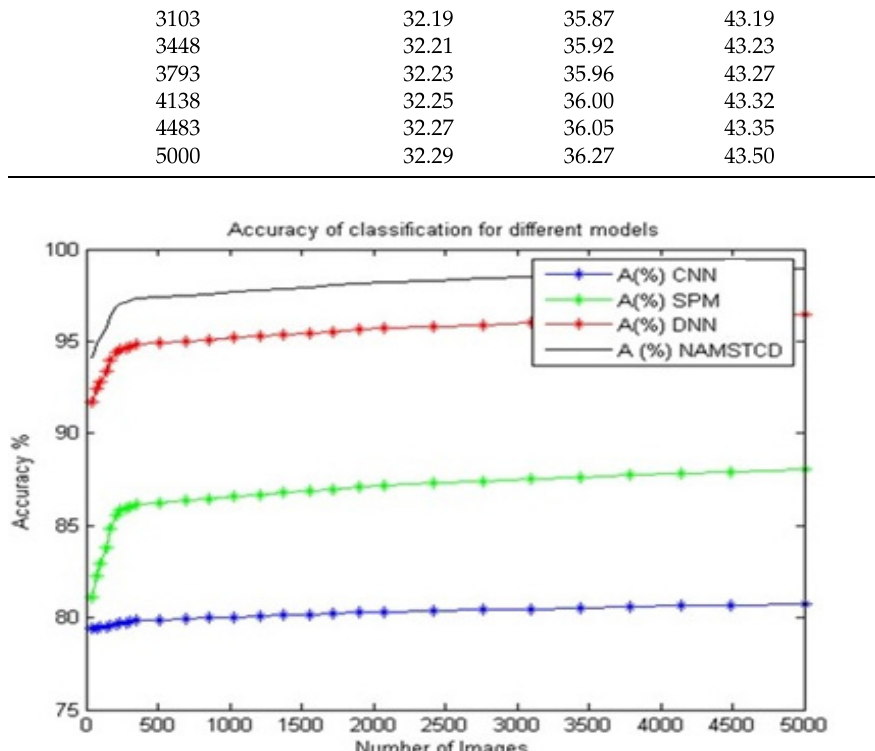
Figure 7. Accuracy of classi fi cation for di ff erent models. This suggests that the proposed model is highly e ffi cient for large-scale deployments and can be used in real-time clinical classi fi cation applications. Similarly, the PSNR during segmentation was evaluated for CNN [5], SPM [8] and DNN [16], and compared with the values obtained for the proposed model; these values are shown in Table 3, below. Table 3. PSNR of segmentation using di ff erent models.